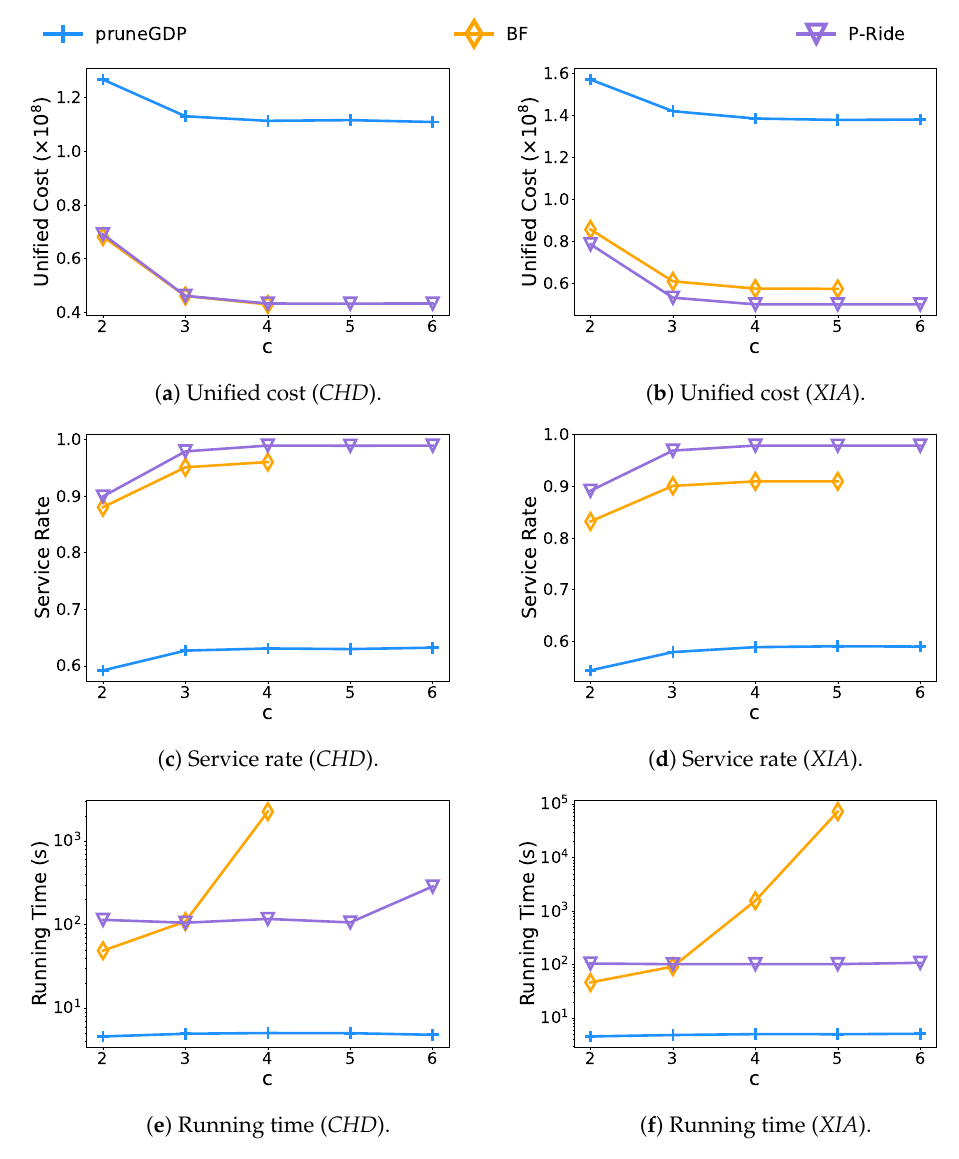
Figure 9. Performance of variance c